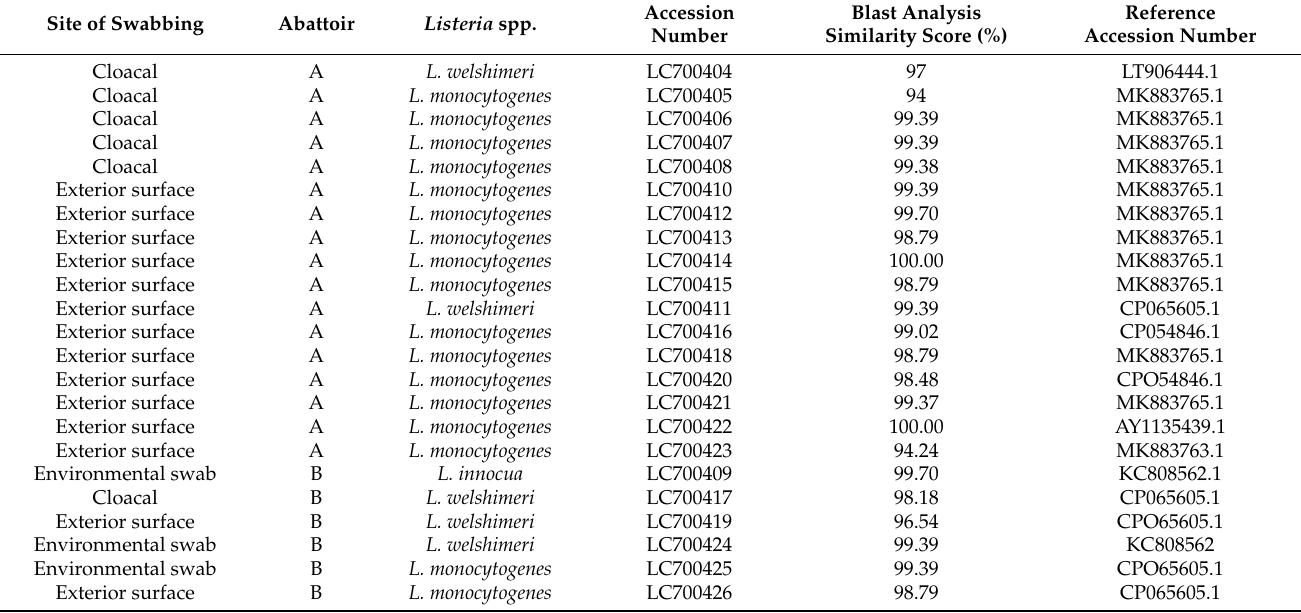
Table 2. Description and BLAST analysis of samples collected from poultry abattoirs in Lusaka. Site of Swabbing Abattoir Listeria